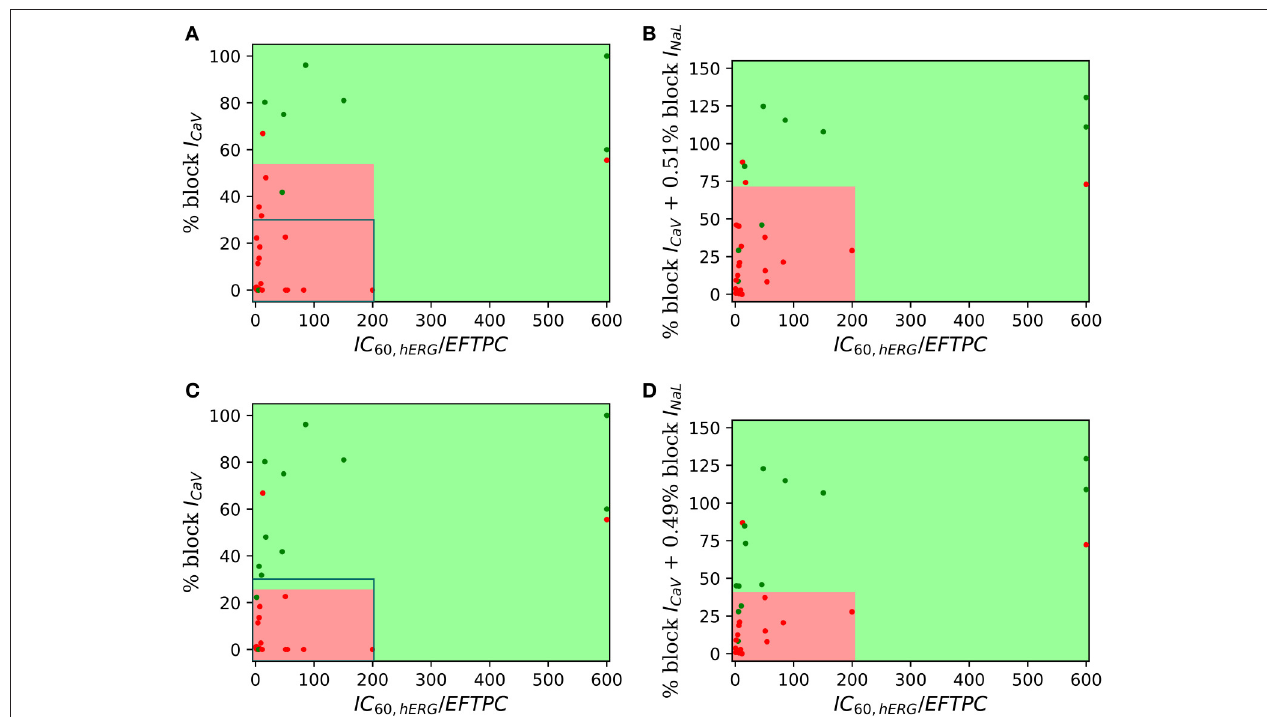
FIGURE 4 | Two-dimensional TdP risk map for Dataset 5 (Crumb et al., 2016). The region in green is a low risk region and the region in red is a high risk area. Red dots ( • ) indicate TdP + drugs and green dots ( • ) indicate TdP − drugs. Blue rectangle outlines the separation of EAD + ( < 30% CaV block) and EAD − ( > 30% CaV block) regions. The misclassified drugs are (A) Ranolazine (CM3, CP3), Cibenzoline (R5), Mibefradil (R4), Saquinavir (CM2) and Amiodarone (CM1, R1); (B) Cibenzoline, Ranolazine, Mibefradil, Ritonavir (CM3), Saquinavir and Amiodarone; (C) Cibenzoline, Ranolazine, Quinine (CM3), Saquinavir and Amiodarone; and